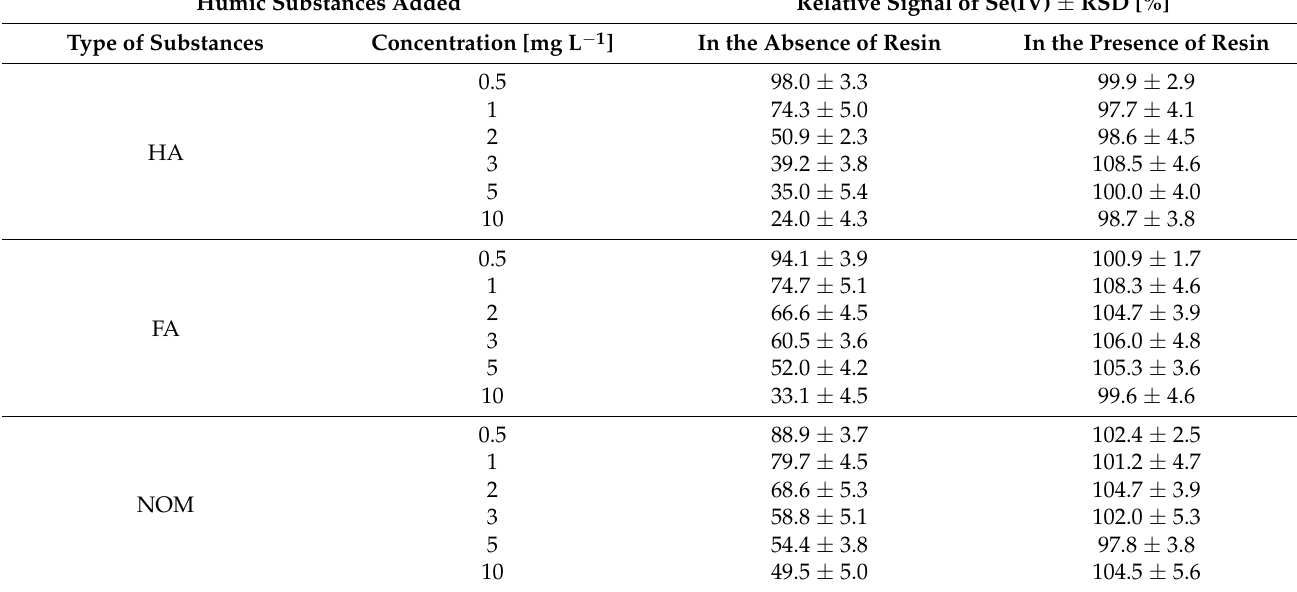
Table 3. Relative signal of Se(IV) in the presence of FA, HA, and NOM in relation to the signal obtained in the absence of these substances. Experiments were performed in the presence and absence of Amberlite XAD-7 resin for a selenium concentration of 5 × 10 − 7 mol L − 1 .